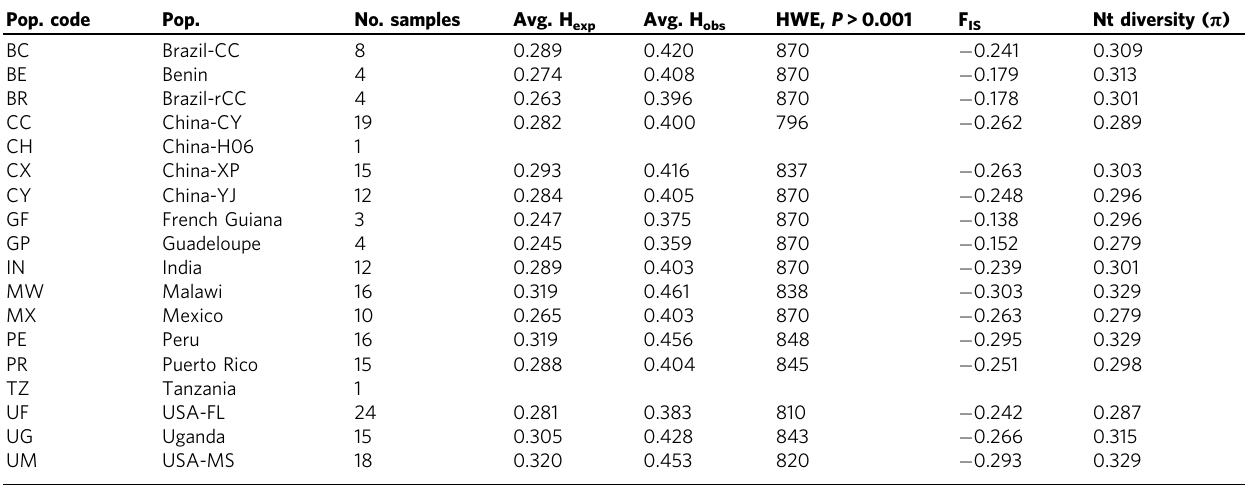
Table 1 Population statistics for native and invasive range Spdoptera frugiperda populations. Pop. code